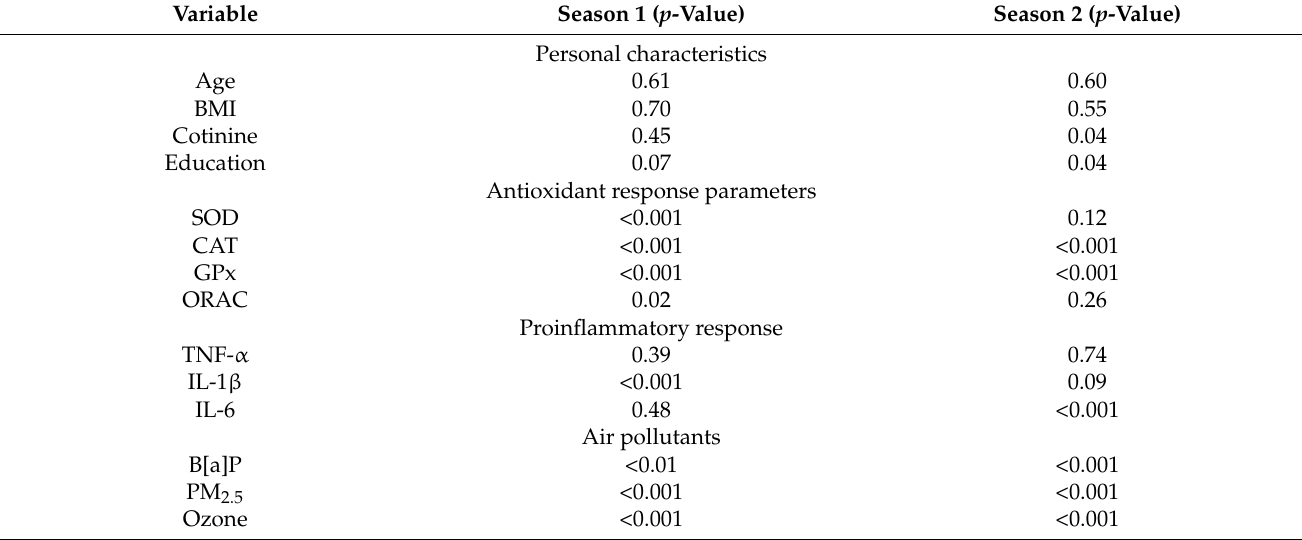
Table 4. A comparison of population characteristics, environmental pollutants, antioxidant and inflammatory response, and oxidative stress markers for individual seasons across the